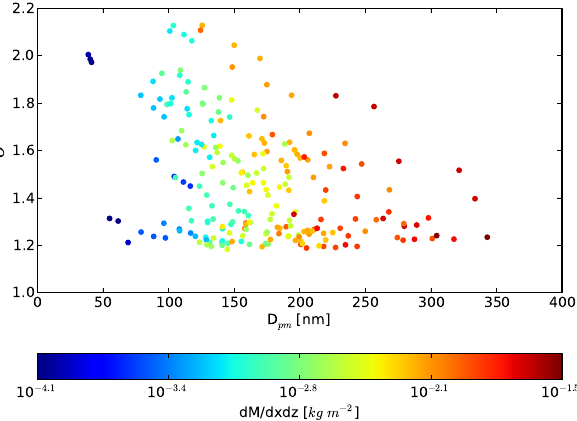
Figure 6. One-to-one plots showing GEM-SA emulator vs. SAM- TOMAS for 624 non-training simulation slices for (a) final D pm and (b) final modal width, σ . The black line is the one-to-one line. The dashed black line is the line of best